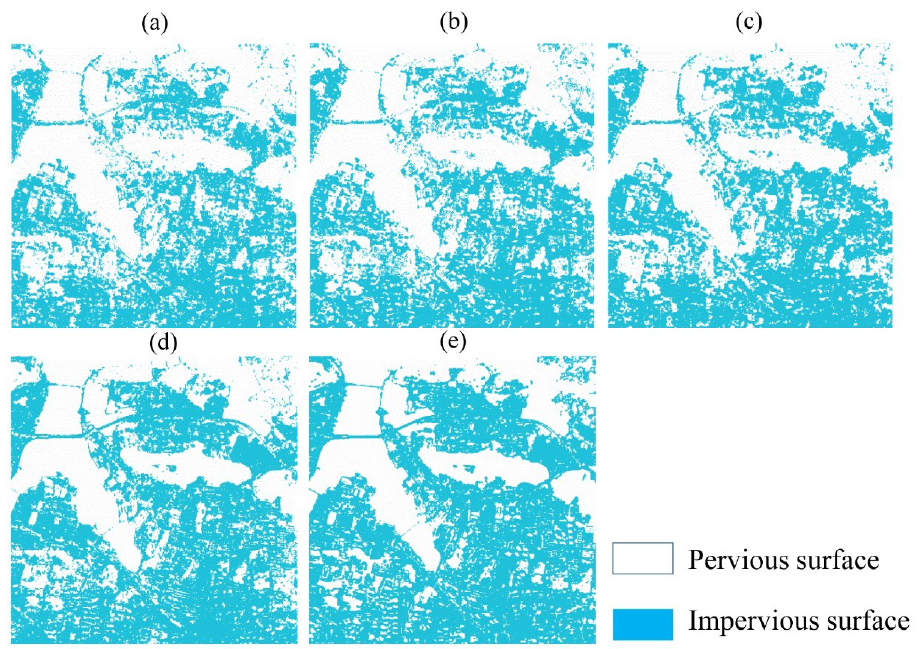
Figure 9. The IS extraction results using different images in Site 1: ( a – e ) IS results of IHS, GTF, DWT, IHS-GTF, and the Sentinel-2A image, respectively.